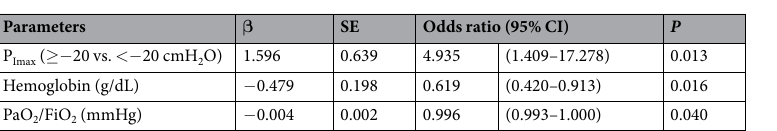
Table 5. Multivariate logistic regression models for significant clinical characteristics associated with weaning failure at respiratory care center discharge * . CI, confidence interval; FiO 2 , fraction of inspiratory oxygen; PaO 2 , arterial partial pressure of oxygen; P Imax , maximal inspiratory pressure; SE, standard error. * Variables with statistical significance ( P < 0.05) in the univariate analyses (Supplementary Tables S2, S3 and S4) were included in the multivariate logistic regression models. Backward variable selection was performed, and the criteria of P values for entry and stay were set at 0.05 and 0.10,